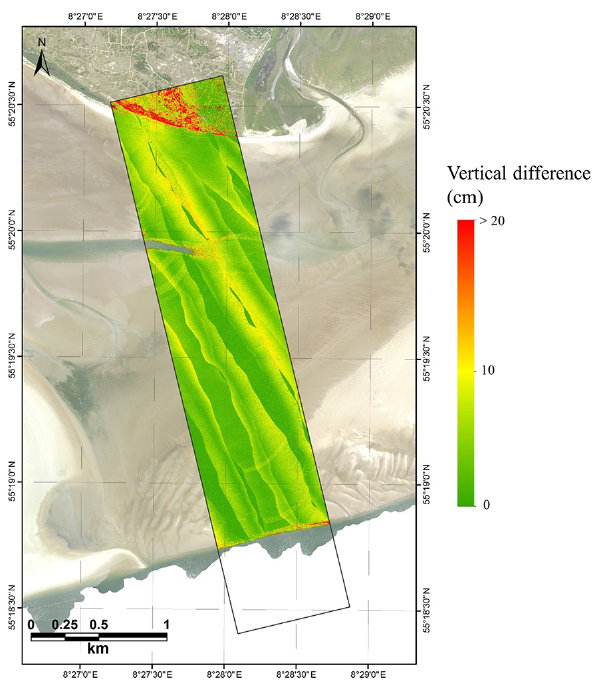
Figure 12. Vertical difference between the highest and the lowest lidar point within 0.5m × 0.5m grid